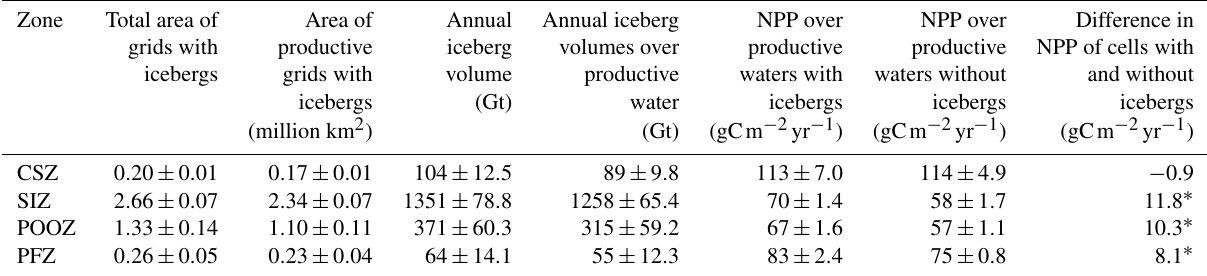
Table 2. Mean annual NPP for grids with and without icebergs 2002–2014. Zone Total area of Area of Annual Annual iceberg NPP over NPP over Difference in grids with productive iceberg volumes over productive productive NPP of cells with icebergs grids with volume productive waters with waters without and without icebergs (Gt) water icebergs icebergs